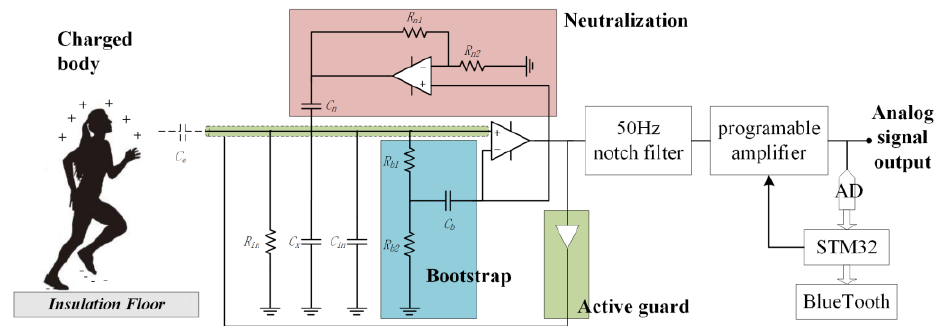
Figure 4. Circuit schematic of the electrostatic potential sensor.